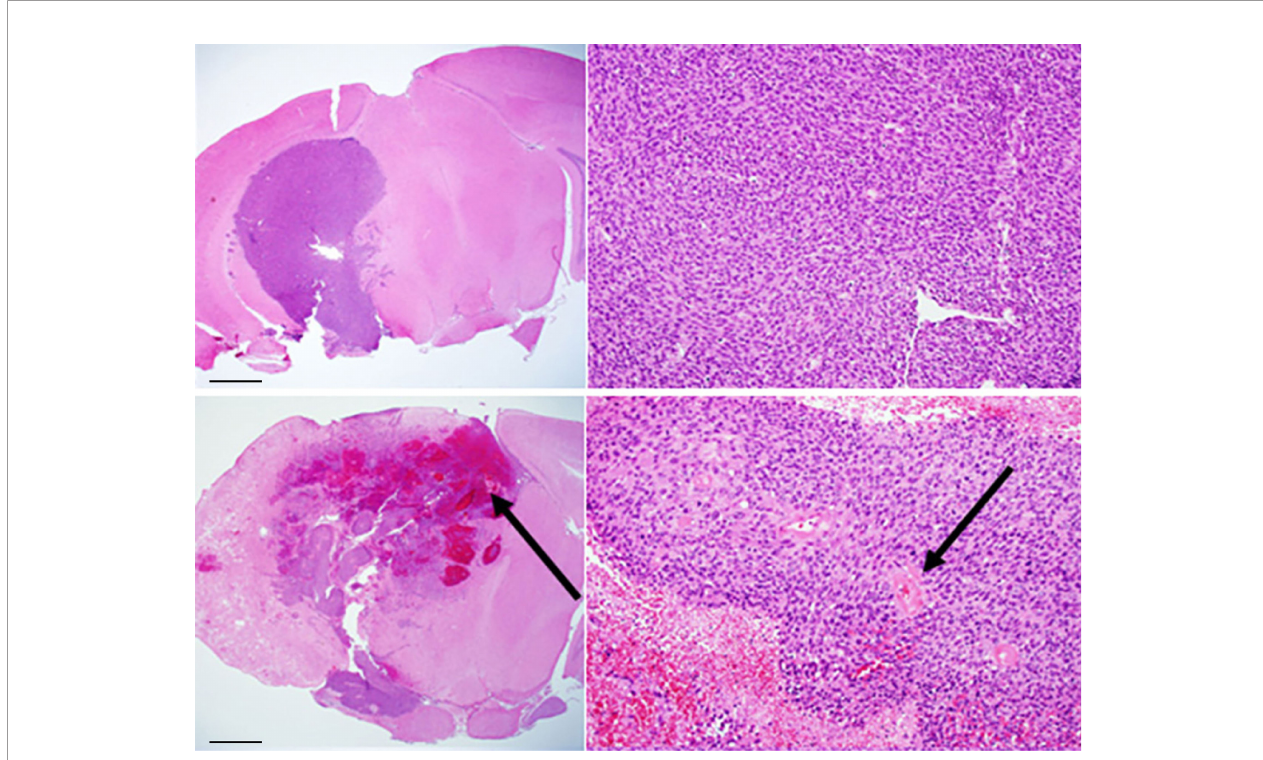
FIGURE 2 | Conventional H&E staining of: (top) GL261 tumor growing in non-irradiated mouse brain (C57BL/6); (bottom) mixed model, with tumor growing within a region of radiation necrosis. Scale bars on the whole-mount images (left) represent a length of 1 mm; the expanded images (right) are at a magni fi cation factor of 10×. Black arrows indicate areas of hemorrhage and necrosis (bottom, left) and vasculopathic changes (bottom,